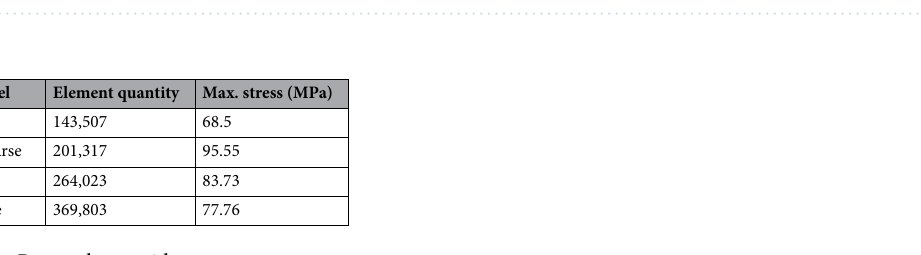
Table 1. Material parameters 10,11 .